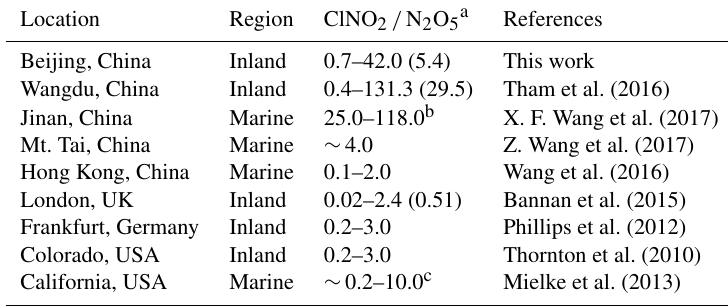
Table 2. Summary of the field-observed ambient ClNO 2 / N 2 O 5 .